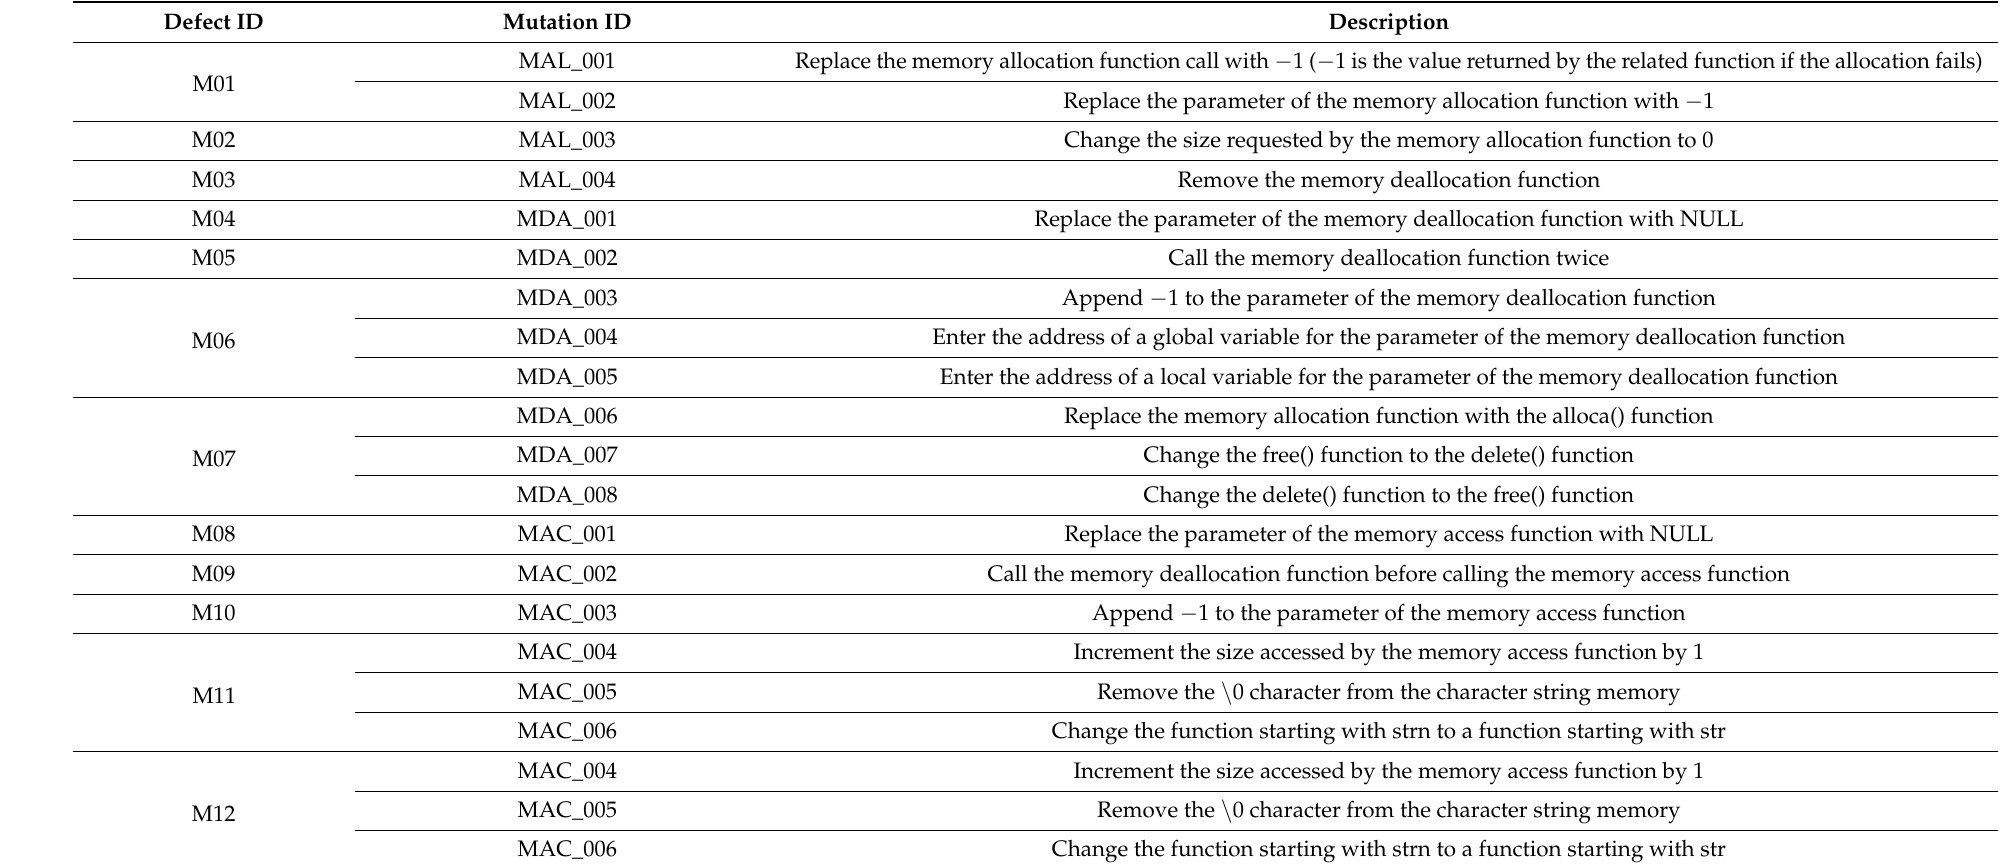
Table 6. Memory mutation